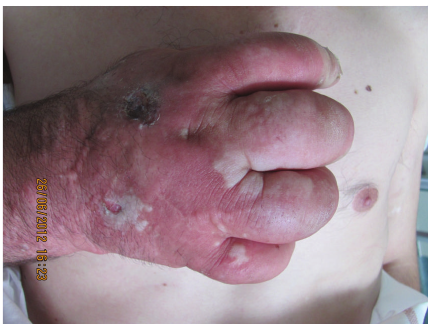
Figure 1: Puffy hand syndrome with large bullous lesions and ery-